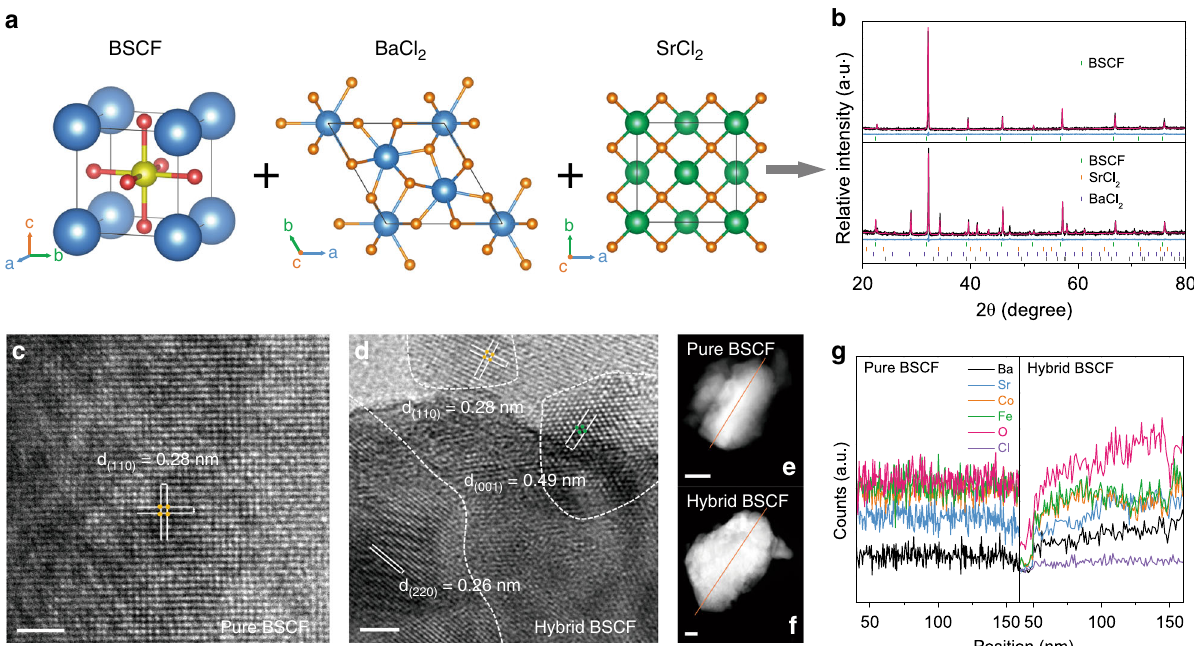
Fig. 2 Synthesis and ex situ characterizations of pure-phase BSCF and hybrid BSCF. a In situ chemical synthesis of hybrid BSCF material with host phase BSCF, hexagonal-phase BaCl 2 and cubic-phase SrCl 2 . b XRD patterns and re fi nements. HRTEM images of c pure-phase BSCF and d hybrid BSCF (scale bar is 2 nm). e – g EDX spectroscopy line-scan pro fi les (scale bar is 50